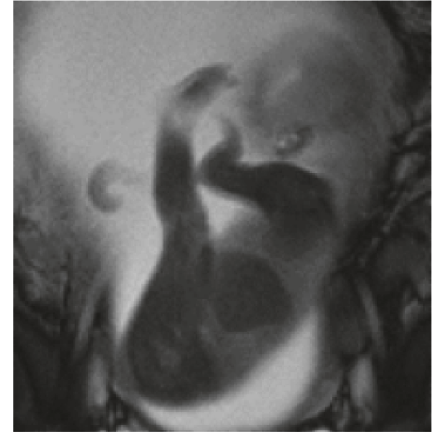
Figure 3: External examination showing a low hairline, synophrys, low-setear, hypertrichosis,and smooth long philtrum with thin lips. The neck appears short and